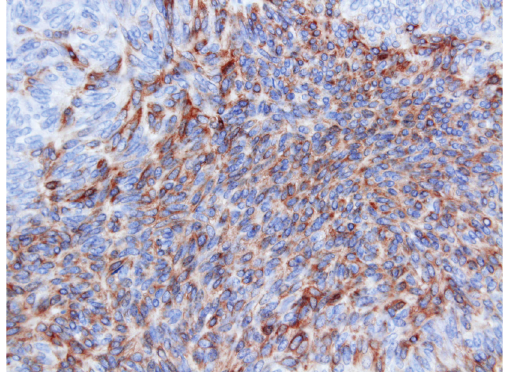
Figure 5: The cells simulating Verocay bodies are positive for AE1/AE3.